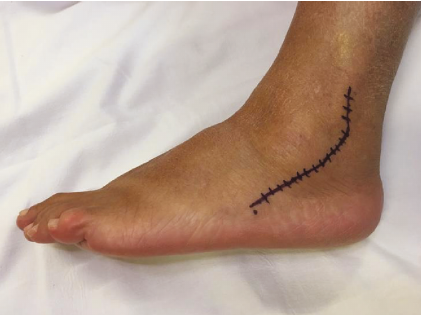
Figure 3: Patient II: the lateral approach is a curved incision starting 3-4 cm above the tip of the lateral malleolus, extending over the course of the PT to the base of the fi fth metatarsal.